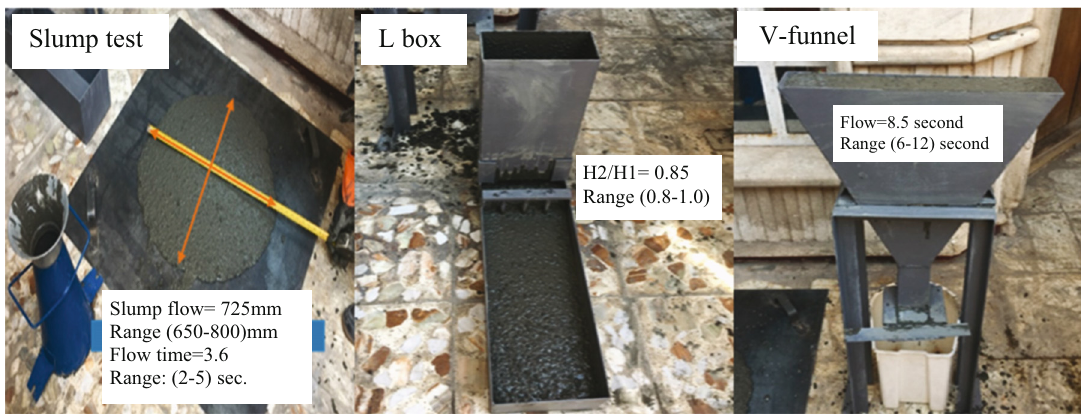
Figure 3: Fresh properties of